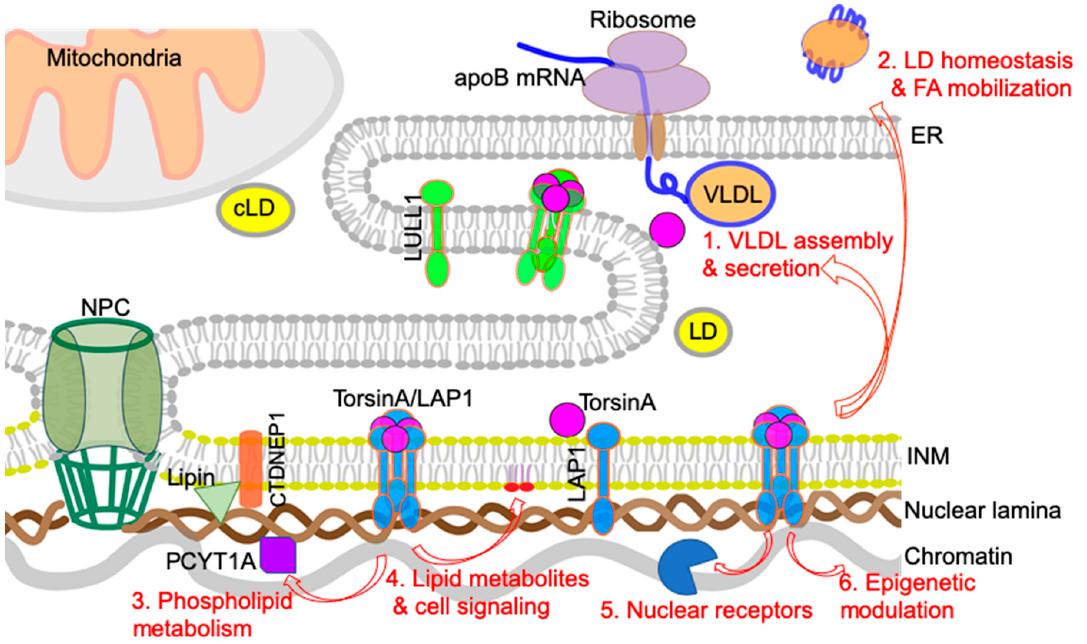
Figure 4. Possible cellular mechanisms that connect defective torsinA / LAP1 complexes at the nuclear envelope to NAFLD / NASH pathogenesis. TorsinA interacts and from a heterohexameric structure with LAP1 in the nuclear envelope or with LULL1 in the ER. Red arrows indicate the plausible cellular pathways that torsinA / LAP1 are involved in in hepatocytes. See text for detailed descriptions.